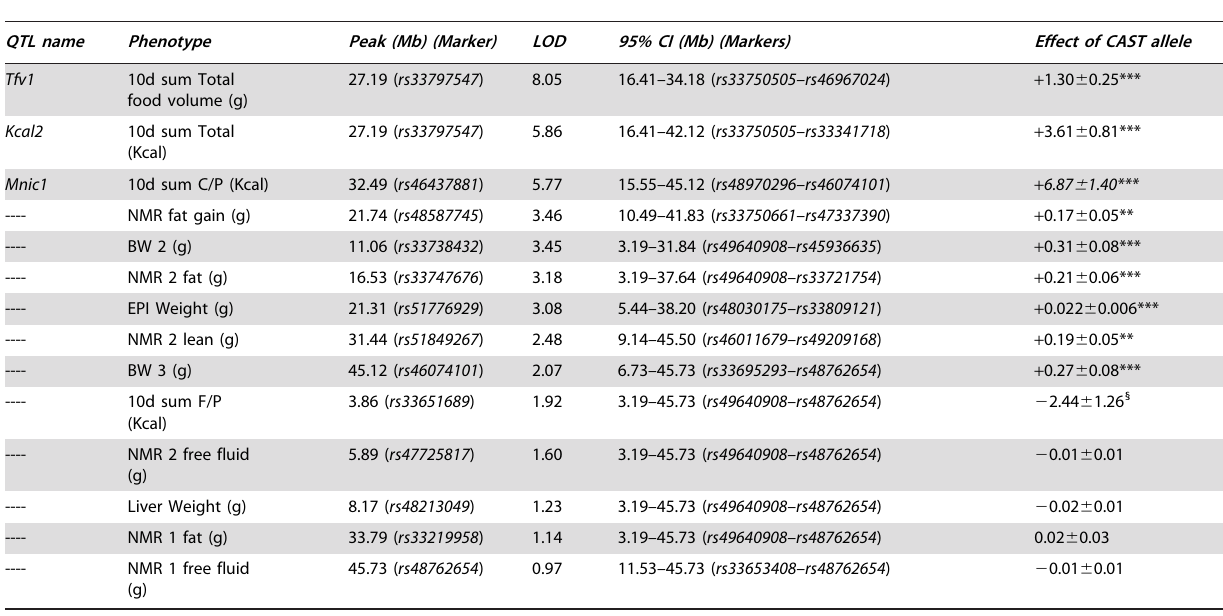
Table 2. QTLs for nutrient intake, body weight, and body composition in B6.CAST-17.1-derived F 2 mice.